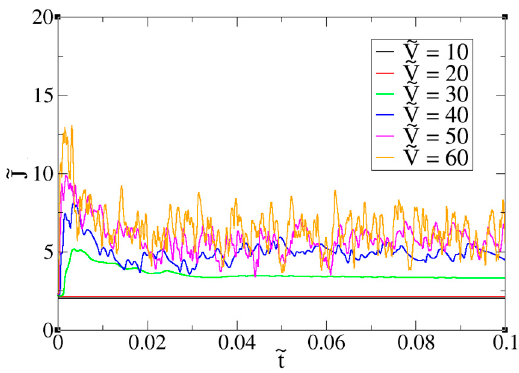
Figure7. Baseline2-Dcase(1mol/m 3 concentration), (cid:101) V = 120. Smoothmembrane. Anionconcentration. Figure 7. Baseline 2-D case ( 1 mol/m (cid:2871) concentration) , 𝑉 (cid:3556) = 120. Smooth membrane . Anion concentration.